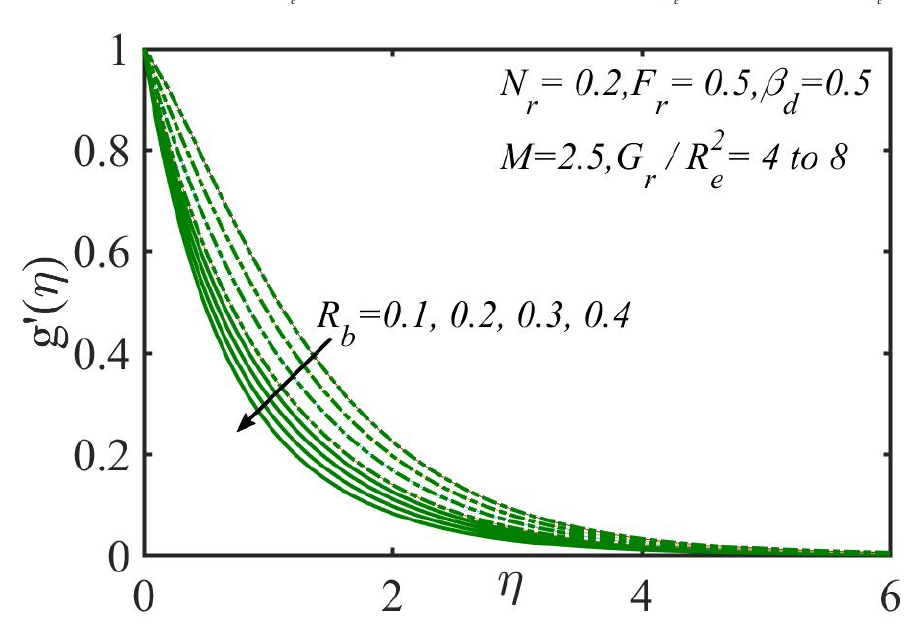
G r R 2 e on velocity distribution. Solid line: (cid:3008) (cid:3293) (cid:3019) (cid:3280)(cid:3118)